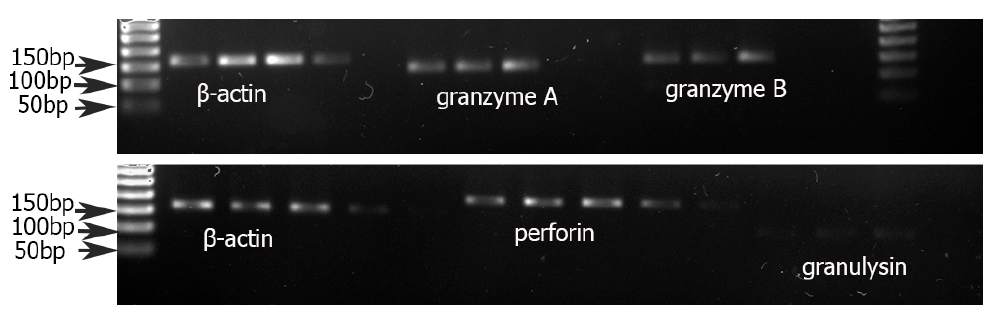
Figure 5. Agarose gel electrophoresis of RT-PCR products from granzyme A (135 bp), granzyme B (149 bp), perforin (200 bp), granulysin (123 bp), and β‐ actin (161 bp) mRNA of CD8 + T cells from maternal peripheral blood.